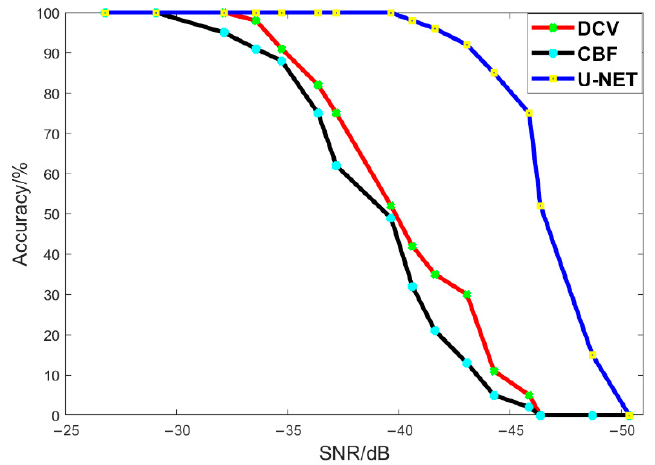
Figure 7. Graph of accuracy versus signal-to-noise ratio, in which the red line represents the decon- volution method, the black line represents the CBF method, and the blue line represents the U-Net method proposed in this paper.